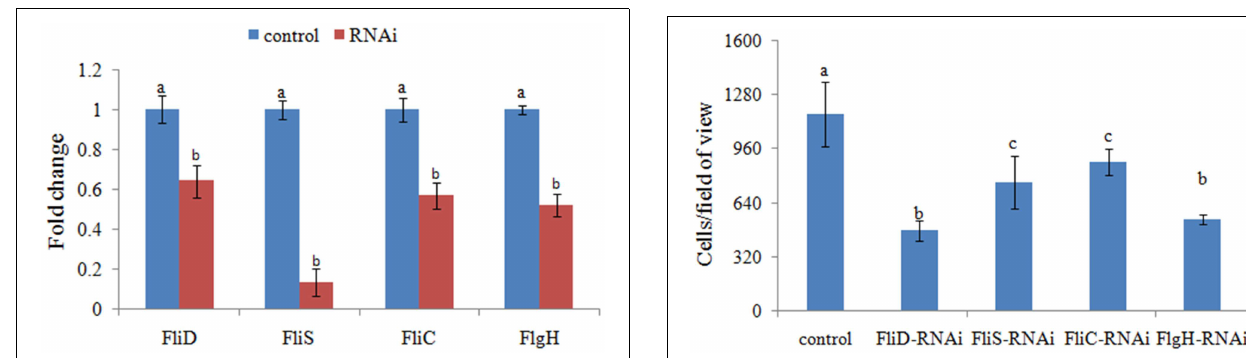
FIGURE 4 | QPCR analysis of the expression of FliD , FliC , FlgH , and FliS after stable gene silencing in comparison to the control. The data are presented as the means ± S.D. ( n = 6 ).The means of the treatments not sharing a common letter are significantly different at P < 0 . 05 .